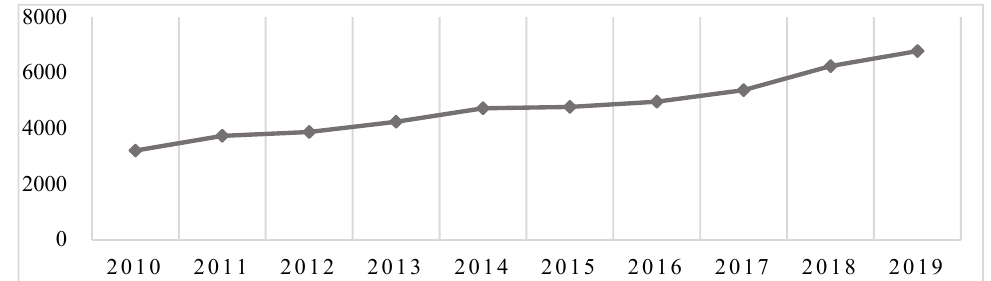
Figure 1. World export of computer information services (Unit: 100 million U.S. dollars). Source: the official websites of WTO.